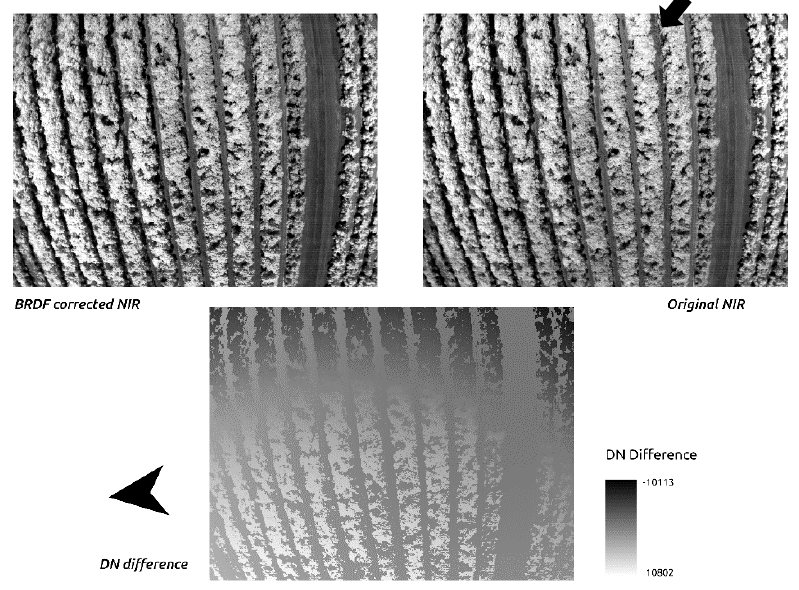
Figure 9. Image comparison before and after BRDF correction. The black arrow shows where the hot spot